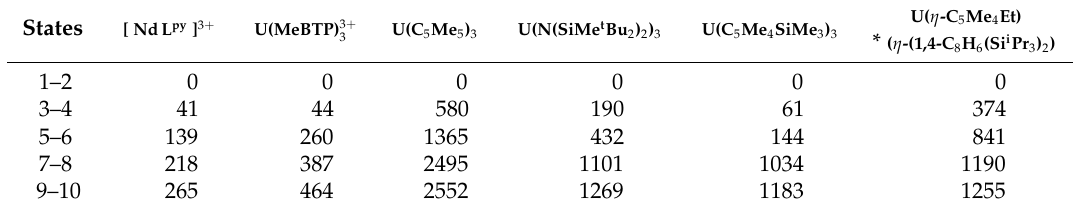
Table 4. Relative energies (cm − 1 ) for the 10 lowest spin-orbit states of the six compounds studied here, showing the increased gap between first and second excited pairs compared to that of the first pair and the ground state